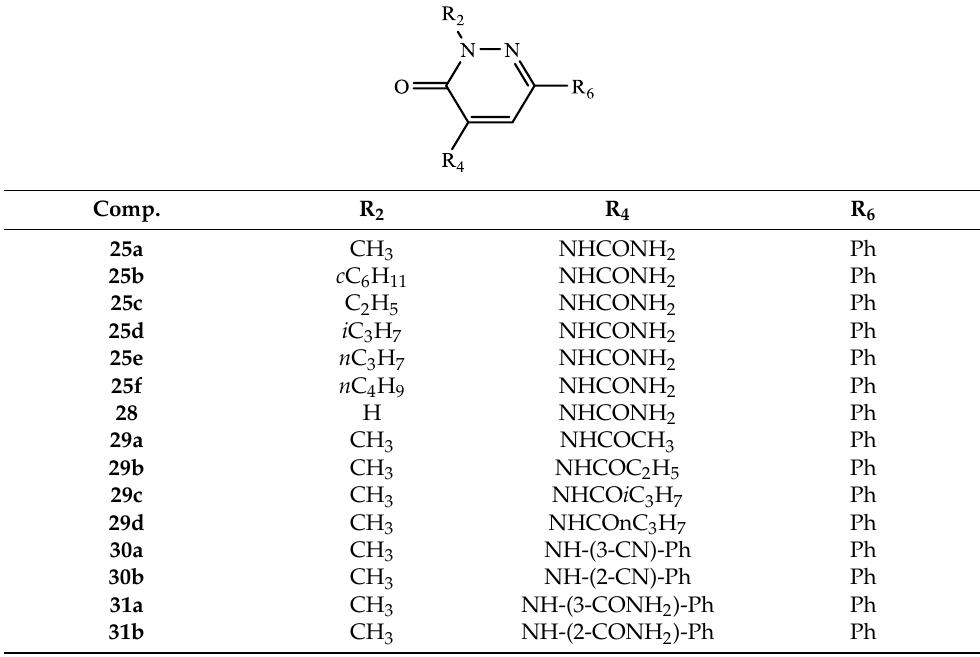
Table 2. 4-Amino and 4-ureido pyridazinones synthesized and screened against FABP4.